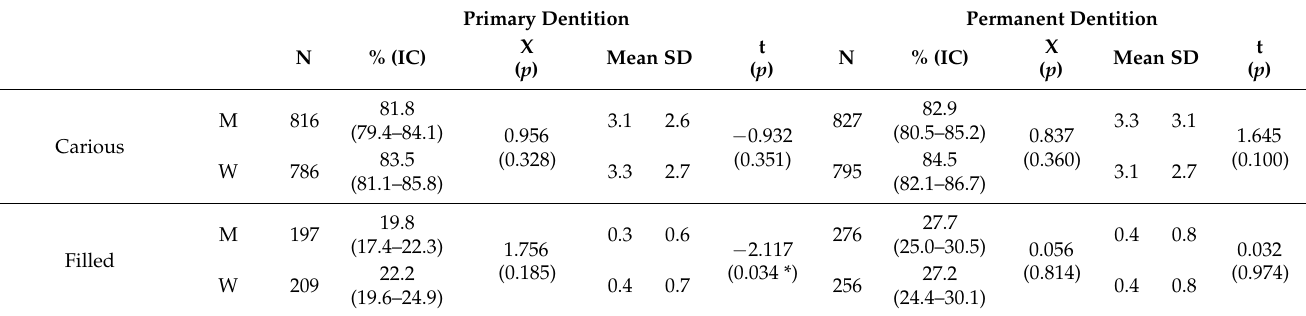
Table 2. Caries experience and treatment needs in urban and rural environments according